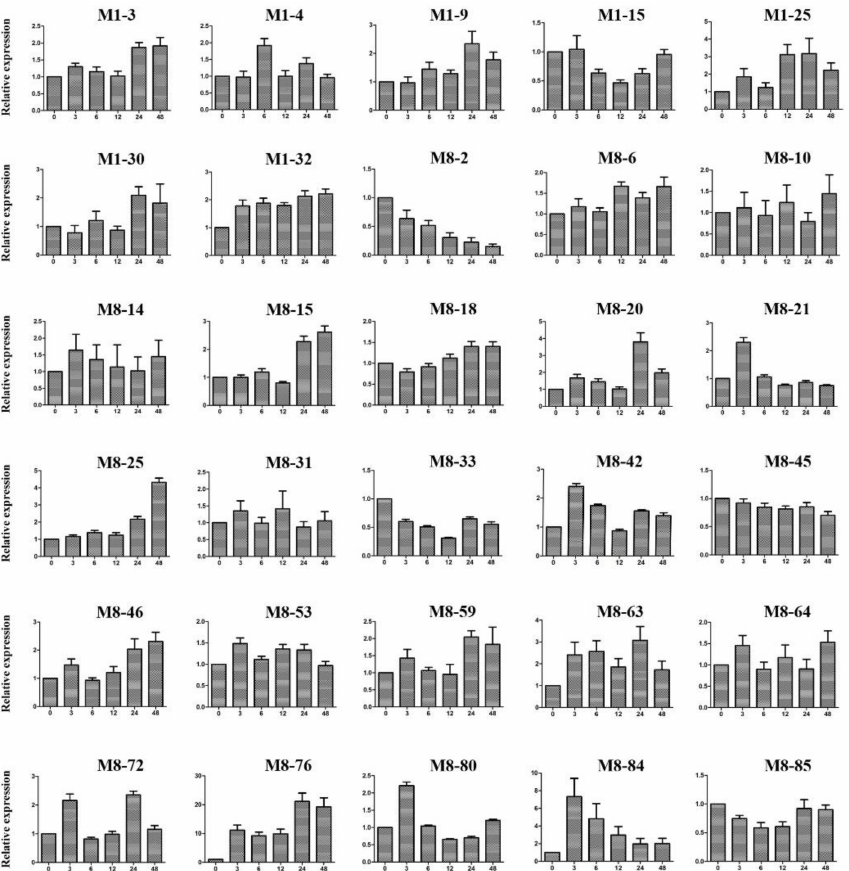
Figure 10. The expression patterns of 30 candidate genes under cold stress conditions. M1-3 (Ci- clev10008657m): BREVIS RADIX-like 4; M1-4 (Ciclev10010581m): elongation factor Ts family protein; M1-9 (Ciclev10007290m): outer arm dynein light chain 1 protein; M1-15 (Ciclev10007673m): receptor- like kinase 1; M1-25 (Ciclev10008981m): galactose mutarotase-like superfamily protein; M1-30